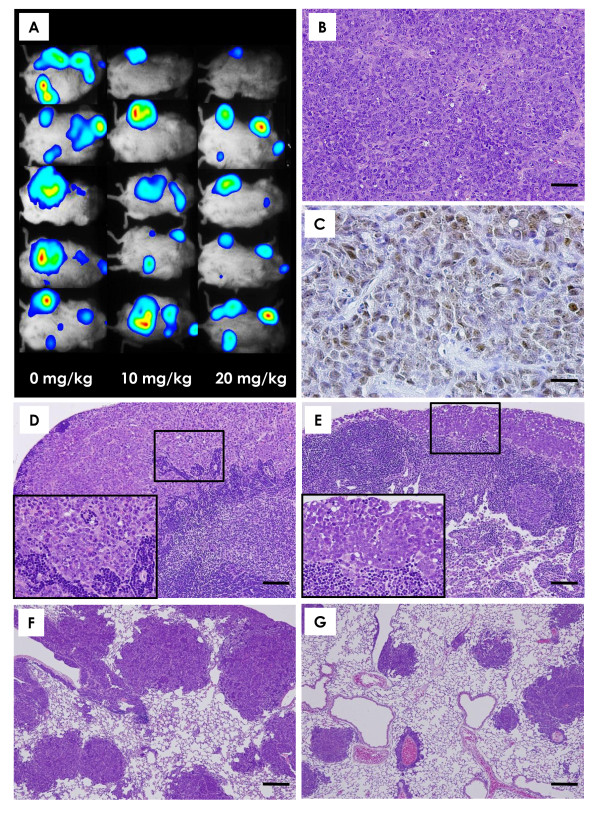
Bioluminescent imaging and histopathological findings. (A) Bioluminescent imaging in five representative mice from each group (0, 10 and 20 mg/kg/day groups). Bioluminescent imaging showed that the extension of metastasis tended to be lower in the α-mangostin-treated groups compared to the control group. (B) The implanted mammary carcinomas proved to be moderately differentiated adenocarcinoma. Scale bar = 50 μm. (C) p53 immunohistochemistry of mammary carcinomas induced by BJMC3879luc2 cell inoculation. Note the nuclear staining for abnormal p53 protein, indicating that these cells carry mutant p53. Scale bar = 25 μm. (D) Metastasis to a lymph node in a control mouse. Scale bar = 250 μm. Metastatic carcinoma cells filled the sinusoidal space (higher magnification in box, inset). (E) A lymph node from a mouse given 20 mg/kg/day α-mangostin. Scale bar = 250 μm. Metastatic carcinoma cells filled the subcapsular sinus (higher magnification in box, inset). (F) Metastatic foci in the lung of a control mouse. Many metastatic foci and small to large nodules were seen. Scale bar = 250 μm. (G) Metastatic foci in the lungs of mice given 20 mg/kg/day α-mangostin. Scale bar = 250 μm. (A): Bioluminescent imaging; (B and D-G): H&E stain; (C): p53 immunohistochemistry.